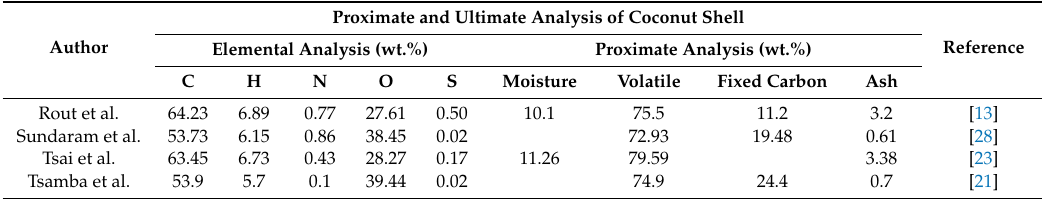
Table 2. Comparison of proximate and ultimate analysis of coconut